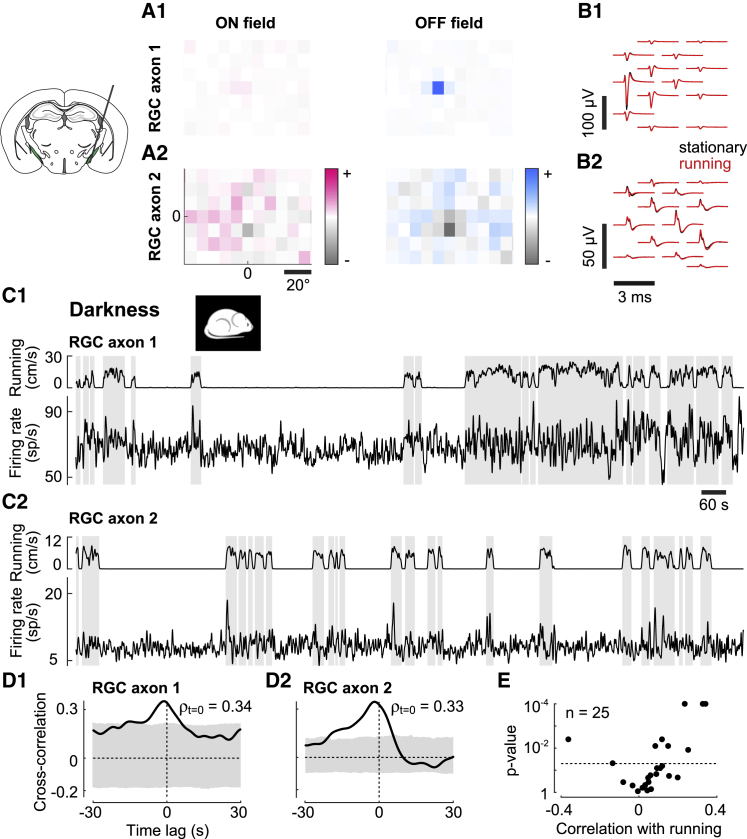
Effect of Arousal Is Present in Firing Rates of Retinal Ganglion Cells(A) ON and OFF receptive fields of example retinal axons 1 (A1) and 2 (A2).(B) Spike waveforms of axon 1 (B1) and axon 2 (B2) on multiple neighboring channels of probe when the animal was running (red) or stationary (black) (recorded in darkness).(C) Traces of running speed (top) and firing rate (bottom) of axon 1 (C1) and axon 2 (C2) recorded in darkness. Grey shades represent periods of running (≥1 cm/s).(D) Cross-correlograms between firing rate and running speed for axon 1 (D1) and axon 2 (D2). A positive lag denotes that firing rate is lagging running speed. Grey shade shows the 2.5th to 97.5th percentile interval of time-shifted data.(E) Correlation strengths (measured at lag zero) with running speed in darkness versus the p value of correlation.